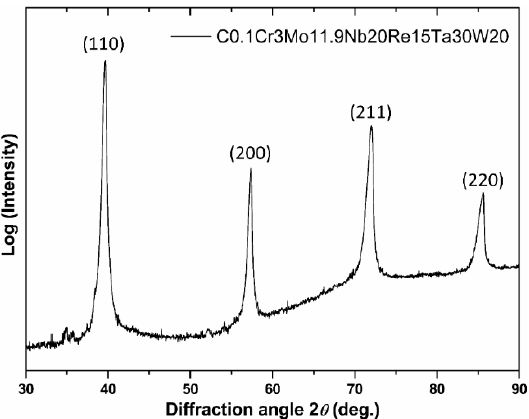
Figure 7. Image showing the XRD pattern of the alloy, with the x -axis and y -axis indicating the diffraction angle and log function of intensity, respectively. The microstructure information of the as-cast C 0.1 Cr 3 Mo 11.9 Nb 20 Re 15 Ta 30 W 20 alloy is